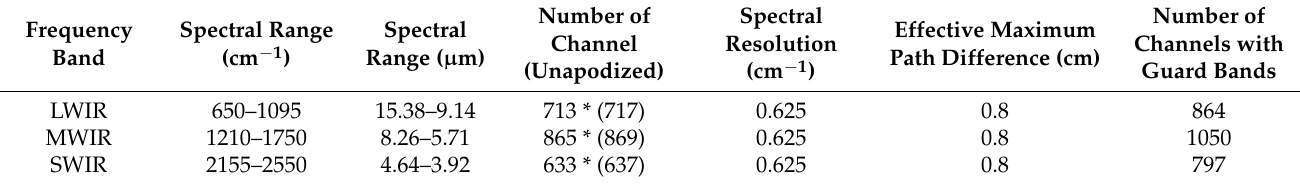
Table 1. The NOAA-20 CrIS instrument and data